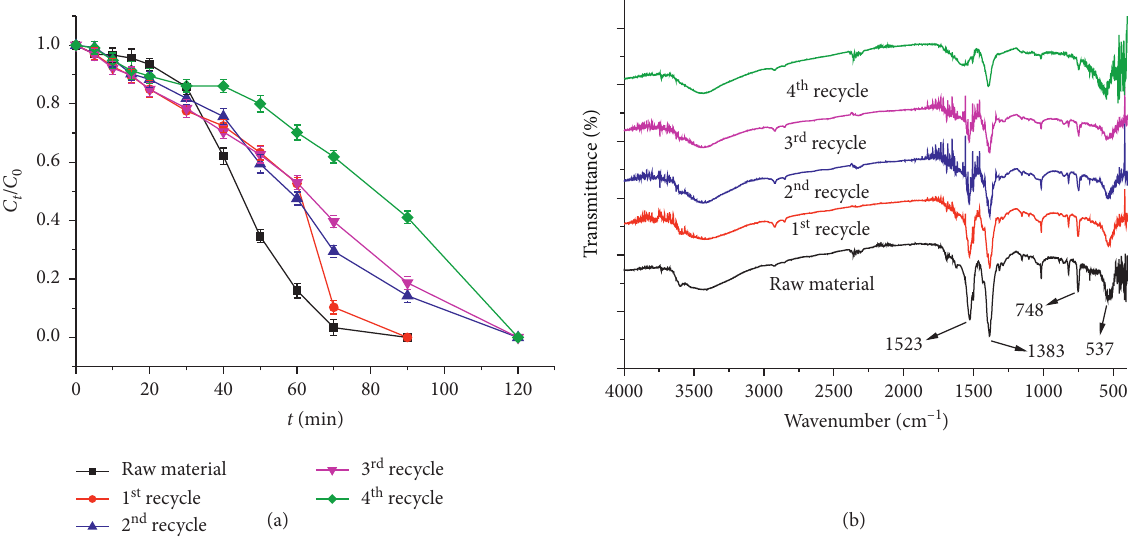
Figure 15: (a) MO decomposition profile by heterogeneous UV/Fenton-like reused MIL-53 catalysts; (b) FT-IR spectra of reused MIL-53 samples (experimental conditions: 0.5g/L of the catalyst; 40mg/L MO; 0.192M H 2 O 2 ; temperature: 30 ° C; UV